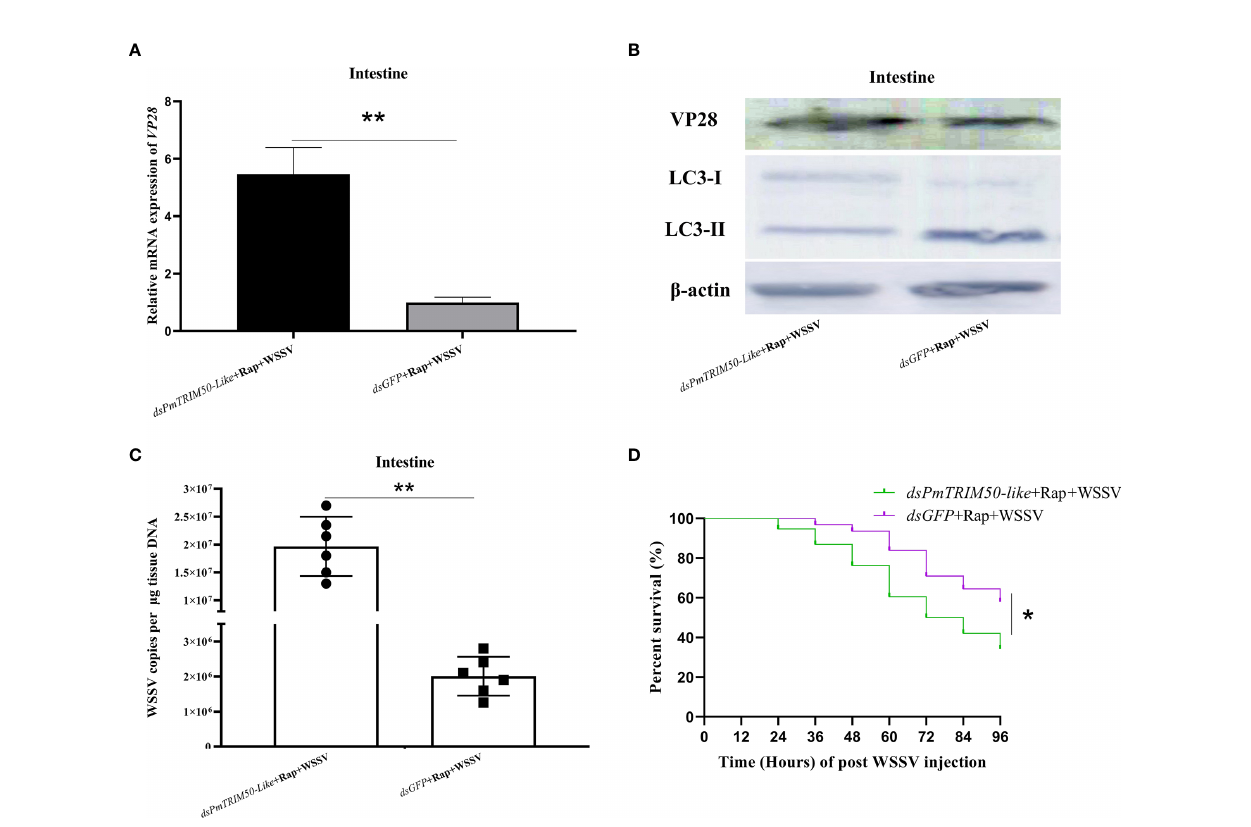
FIGURE 5 | PmTRIM50-like restricted WSSV infection via mediating autophagy in shrimp. (A) The expression of VP28 in dsPmTRIM50-like +Rap+WSSV and dsGFP +Rap+WSSV groups was detected by qRT-PCR. (B) The expressions of VP28 protein (upper panel) and LC3-II/LC3-I (middle panel) in dsPmTRIM50-like + Rap+WSSV and dsGFP +Rap+WSSV groups were detected by western blotting. b -actin was used as control (lower panel). (C) Virus copy number of WSSV in the intestines of dsPmTRIM50-like +Rap+WSSV and dsGFP +Rap+WSSV groups were detected by qPCR. (D) The survival rates in dsPmTRIM50-like +Rap+WSSV and dsGFP +Rap+WSSV groups were recorded. The survival rates were calculated and survival curves were presented as Kaplan-Meier plots. Differences between the two groups were analyzed with log-rank test using the software of GraphPad Prism 8.02. The experiments were repeated three times. Asterisks indicate signi fi cant differences * P< 0.05 and ** P <0.01